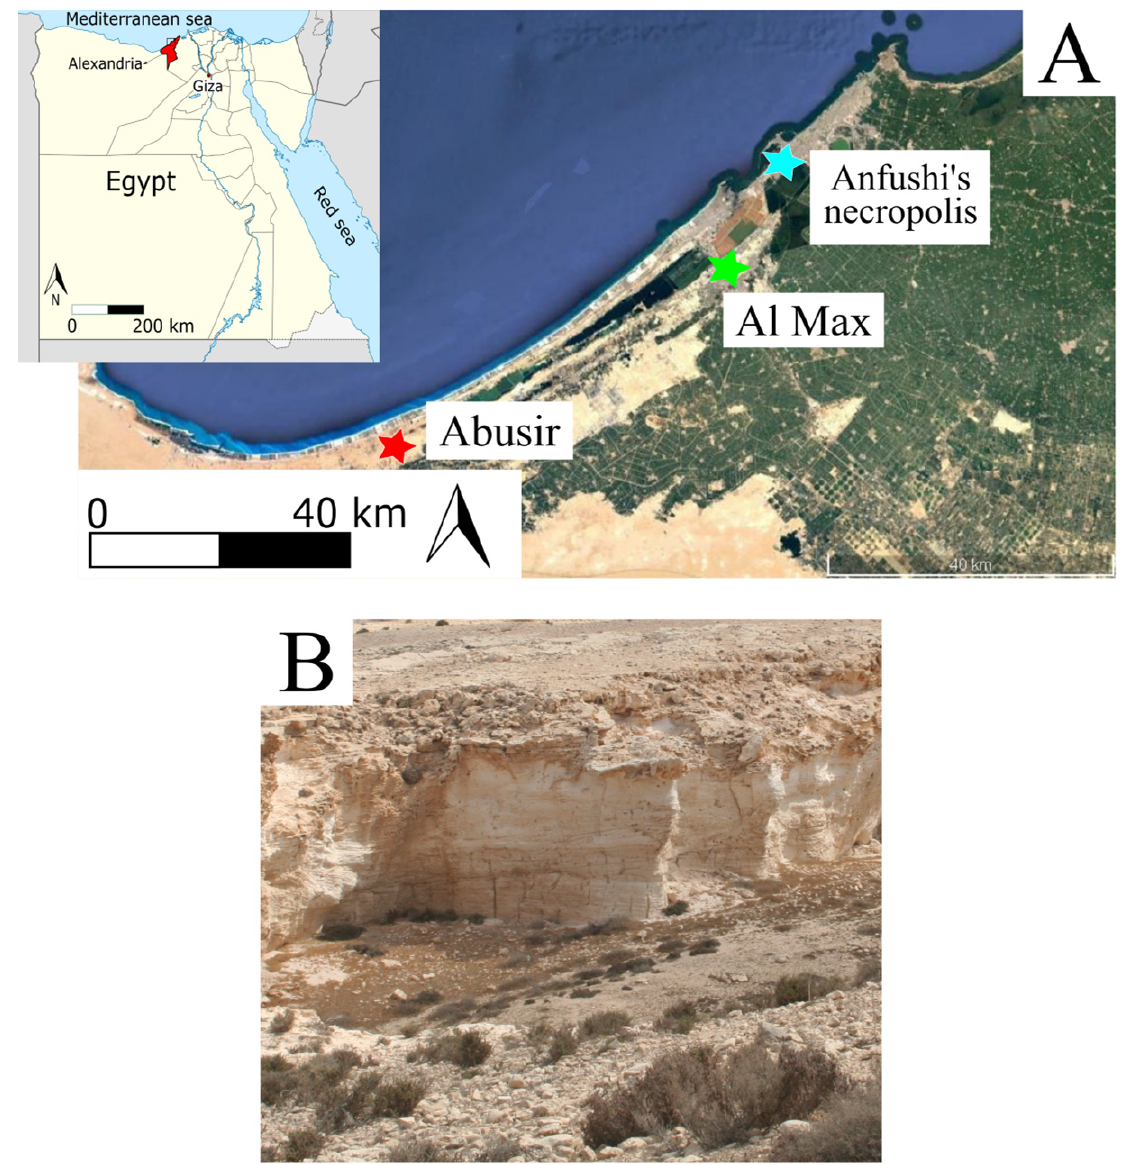
Figure 5. ( A ) Ancient quarries in Alexandria (green and red stars) with an example of the light- coloured of limestone outcrop ( B